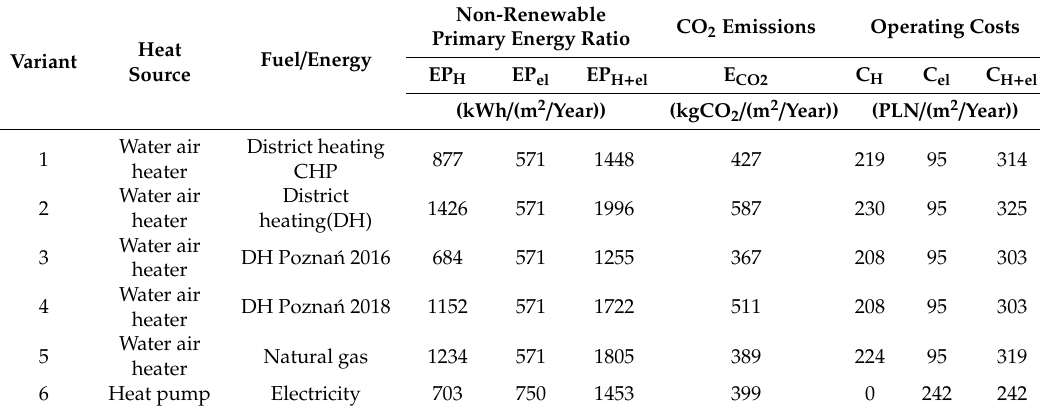
Table 7. Results of the calculations of the non-renewable primary energy ratio EP, CO 2 emissions E CO2 , and the operating costs C—sports pool B1.